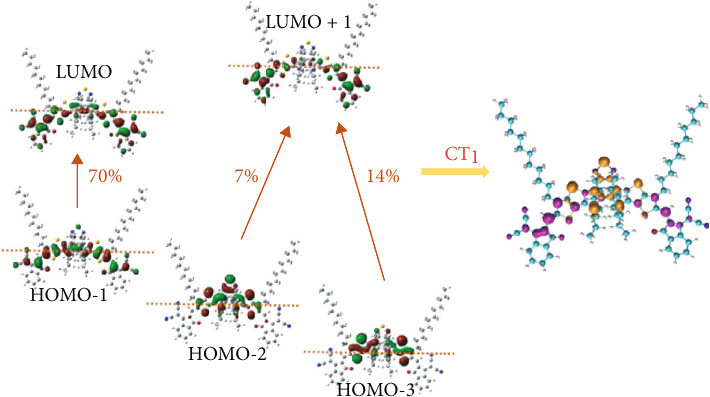
Figure 8: The CT